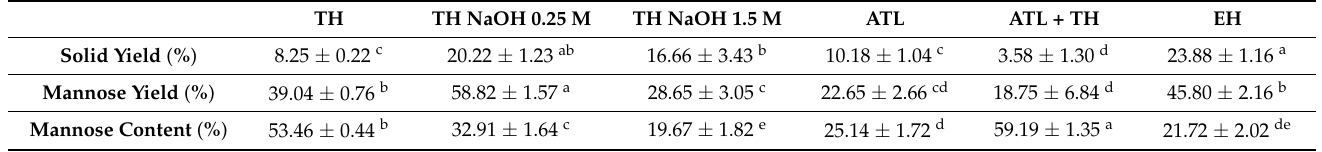
Table 1. Solid and mannose yields and mannose content of mannan extracts obtained by different extraction methods (TH, TH NaOH 0.25 M, TH NaOH 1.5 M, ATL, ATL + TH and